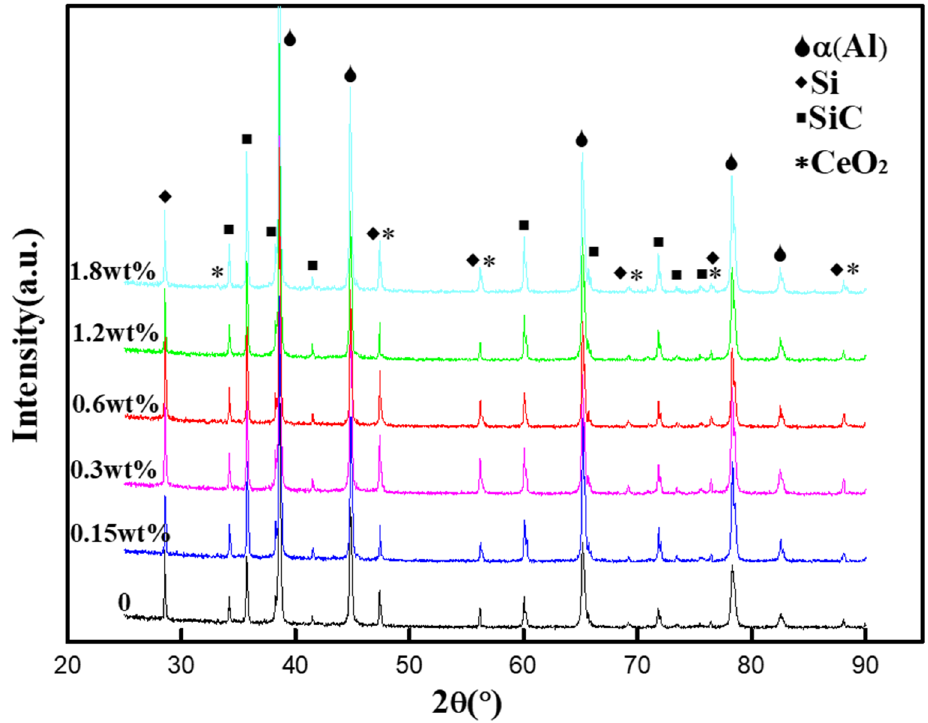
/ Al-Si Composites with di ff erent CeO